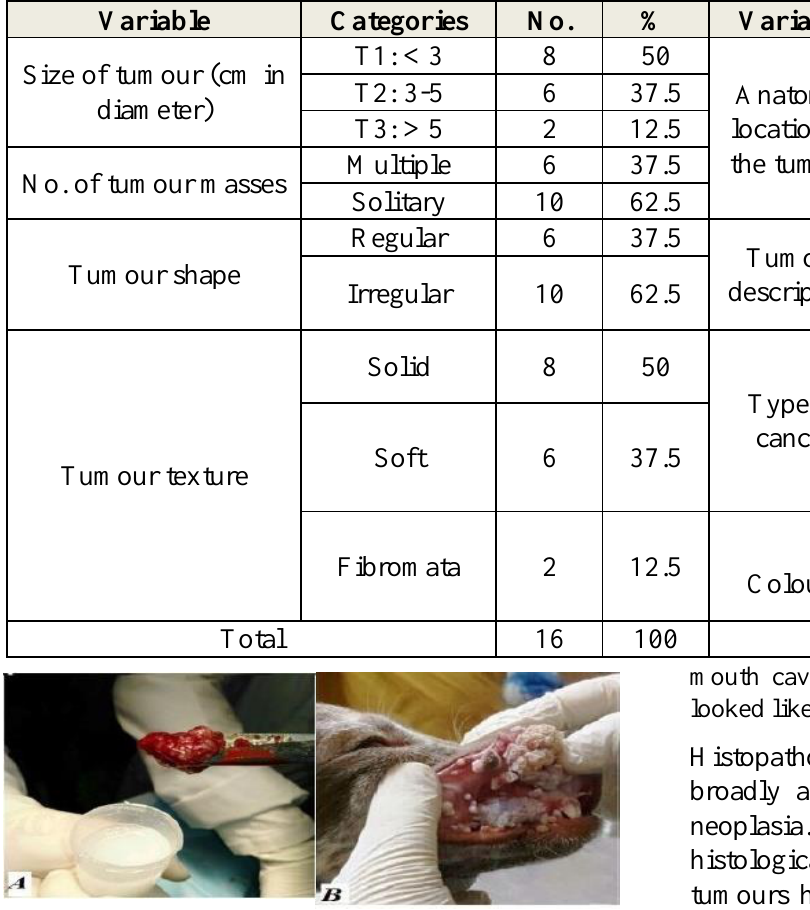
Figure 1. Examples of apparent digestive tract tumour lesions seen in two dogs. A: A spongy lobular, congested and ulcerated mass, 3 cm in diameter from German Shepherd dog aged 8 years which localised as a lump in anus area, B: Belgian Malinois puppy of 6 months of age had viral papillomas on lips, gum and